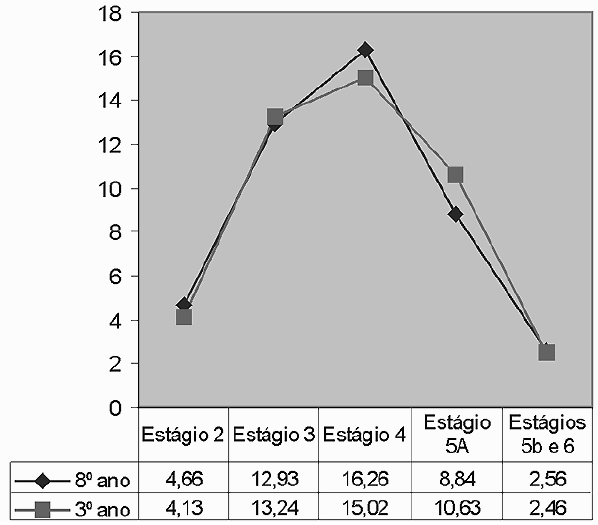
Figura 4. Pontua(cid:231)ªo mØdia bruta dos jovens brasileiros de 8” ano e 3” ano no DIT-2.